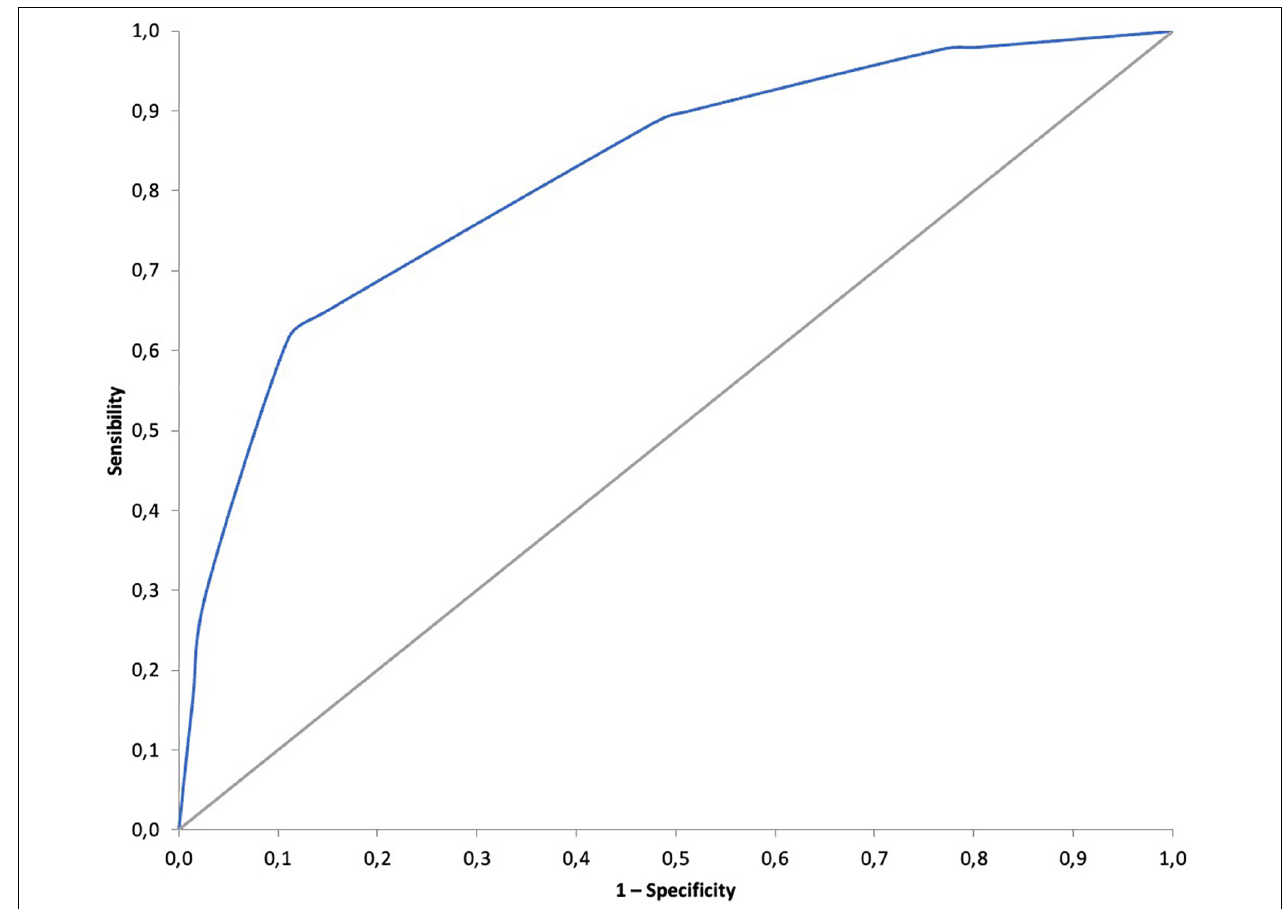
FIGURE 2 | Area under the ROC curve (AUC) of the PATCOM score. PATCOM, Pulmonary Artery Thrombosis in COVID-19 Mallorca; ROC, receiver operating